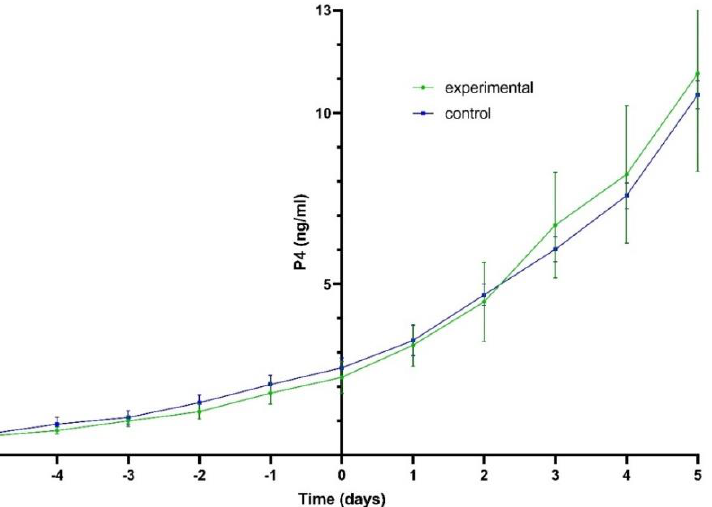
Figure 1. The profiles of P4 (ng/mL, mean ± SE) in peripheral plasma in experimental bitches treated with aglepristone ( n = 7) and in control bitches ( n = 7). Hormone profiles were related to the day of the LH peak (Day 0).